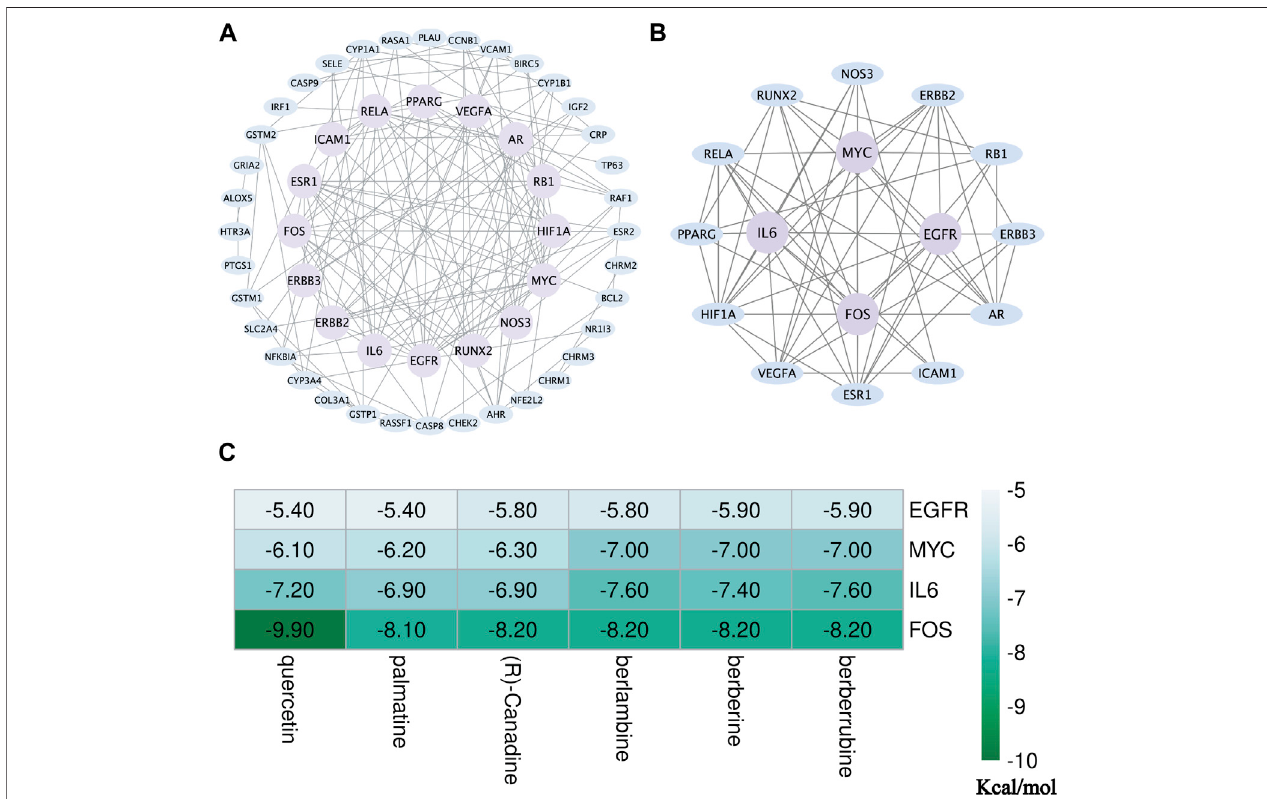
FIGURE5| Identi fi cationofthecoretargets ofCCFinthetreatmentofUTIs. (A) First PPInetworkcontaining52nodesand 149edgeswasidenti fi edviaCytoNCA. The blue nodes represent the target genes, while those highlighted in purple represent the selected genes ranked in the top 50% for BC, CC, DC, EC, NC, and LAC; ( B) second PPI network containing 16 nodes and 62 edges, where the purple areas represent the core targets; (C) thermogram shows the docking score of the selected component – target interaction. The greener the color of the term, the greater the possibility of the molecular interaction.